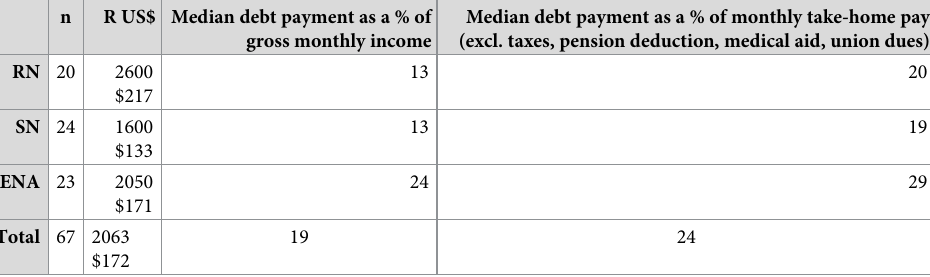
Table 8. Median monthly expenditure on debt by of